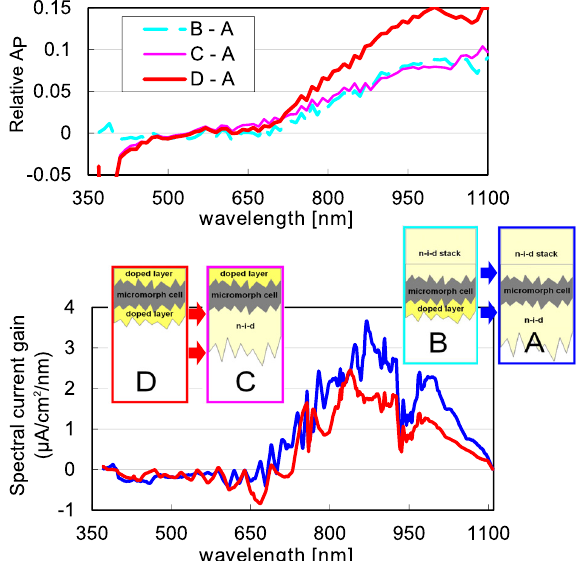
Fig. 3. (a) Relative parasitic absorption in the four micro- morph devices sketched in Figure 1 compared to case A where both electrodes are non-intentionally-doped doped, and thus very transparent. (b) Spectral current density gain between configurations B and A, or D and C. In both cases, the same modification is made at the back electrode.